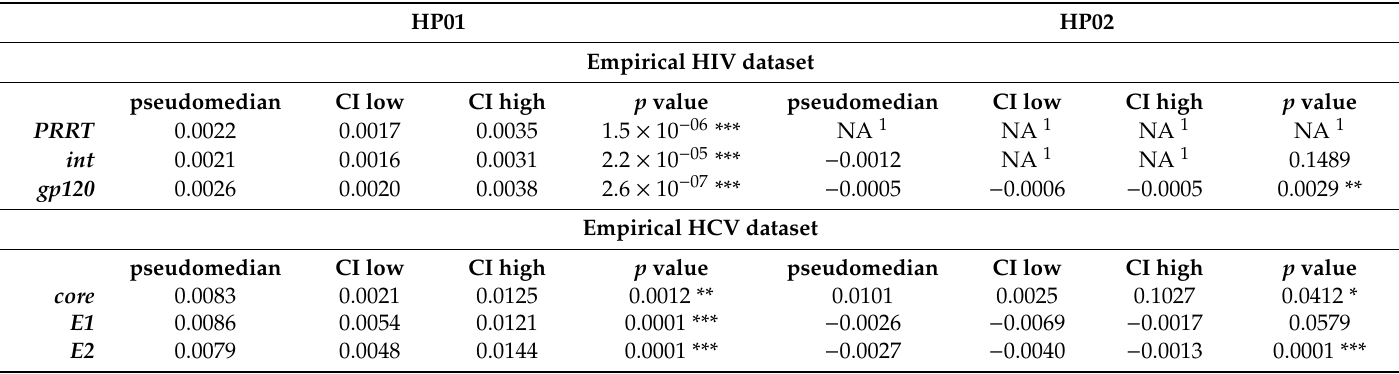
Table A6. Wilcoxon signed-rank comparisons of the adjusted genetic p-distance from the reference sequence between the initial and final consensus sequences constructed in the HAPHPIPE pipelines for the empirical HIV and HCV datasets. The reference sequences for HIV and HCV were HXB2 and H77,